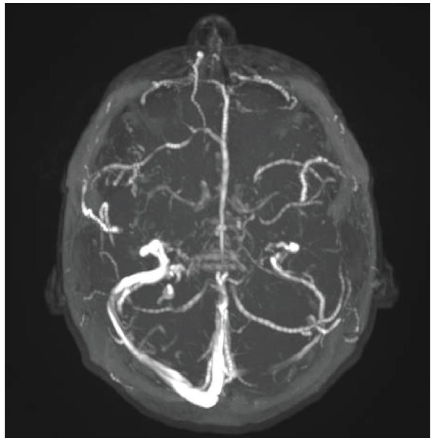
Figure 1: Magnetic resonance venography: T 1 hyperintensity with lack of enhancement in the lateral aspect of the left proximal sigmoid